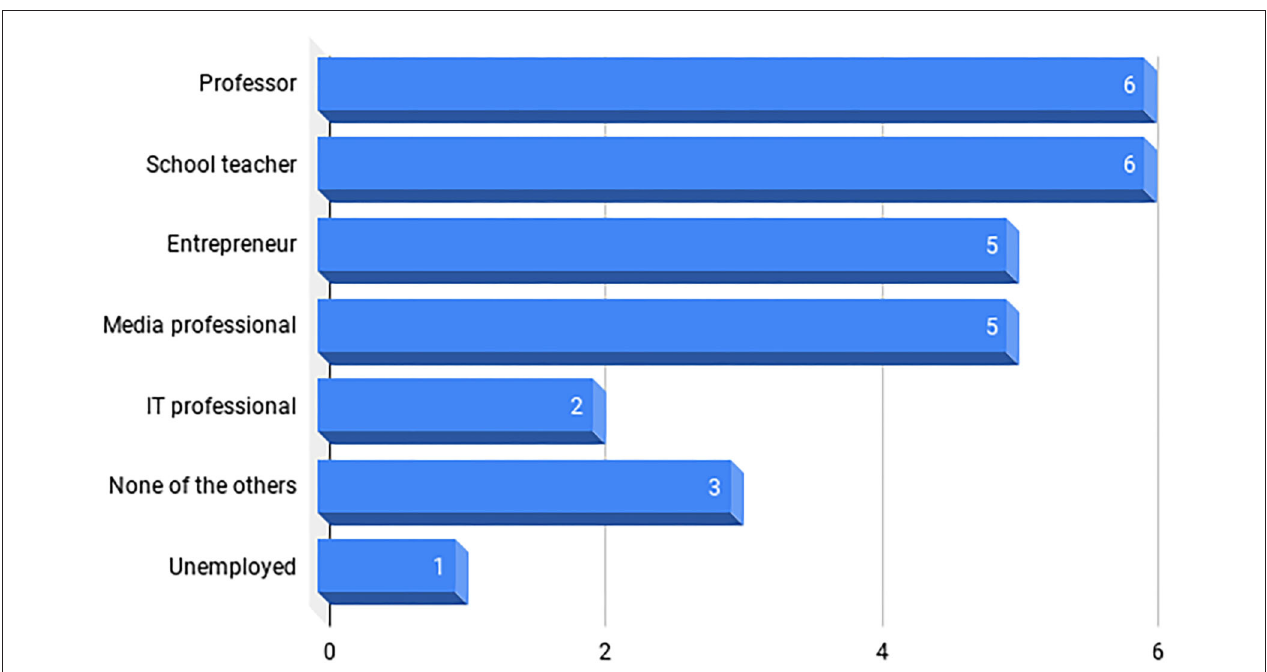
FIGURE 5 | Occupations of science Youtubers.